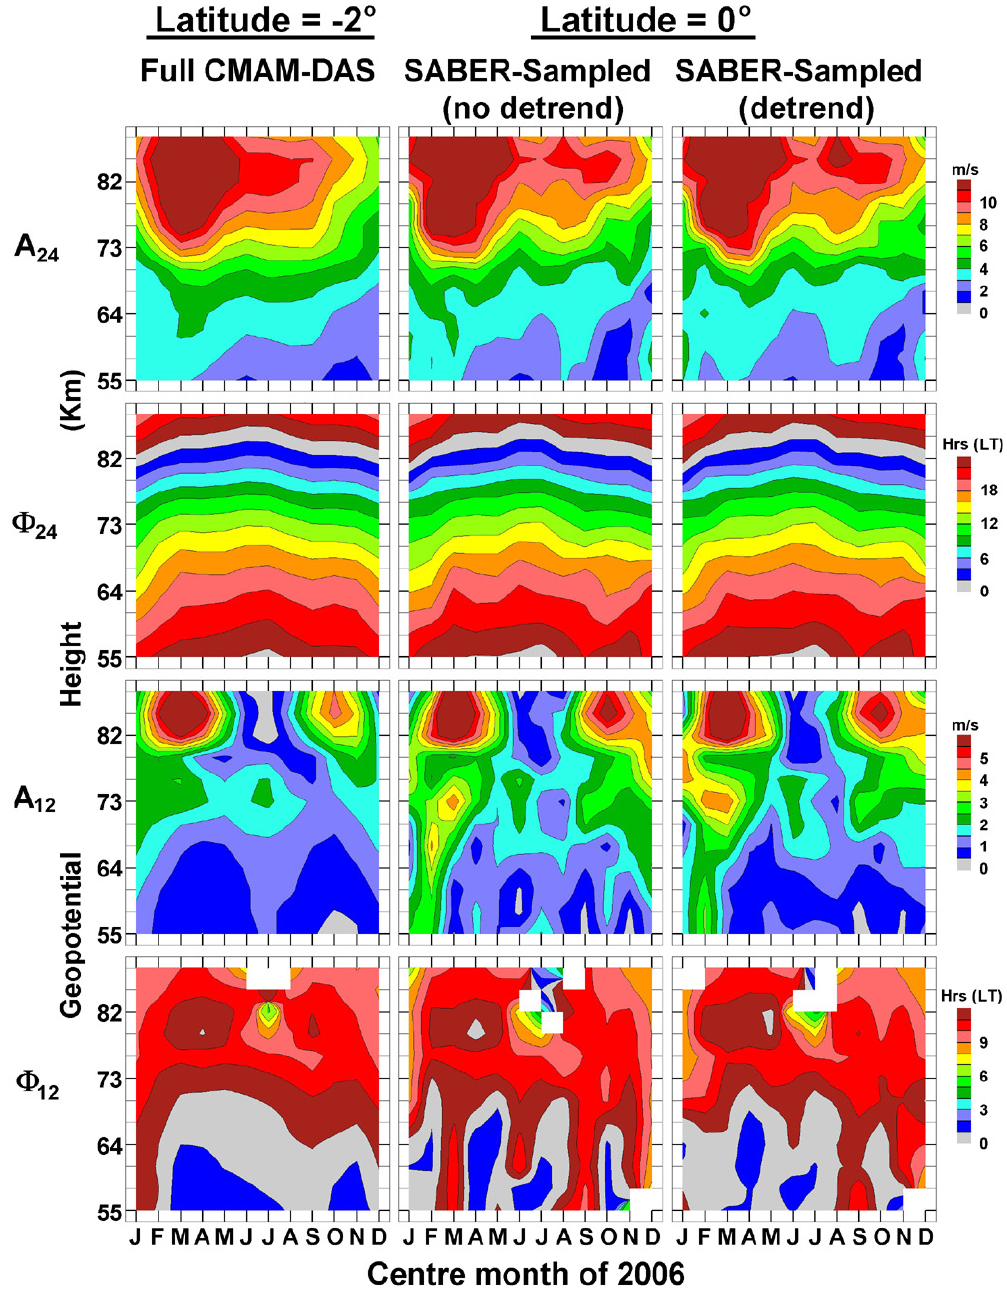
Fig. 3. Tidal analysis of Full CMAM-DAS data (no detrend) with SABER-sampled CMAM-DAS (without and with detrend) at latitudes − 2 ◦ N and 0 ◦ , respectively. Fits of 24 and 12h tides to 60d intervals centred on calendar months. Mean (and trend in the right hand column) were included in the least squares fit, but just the amplitude and hour of maximum are